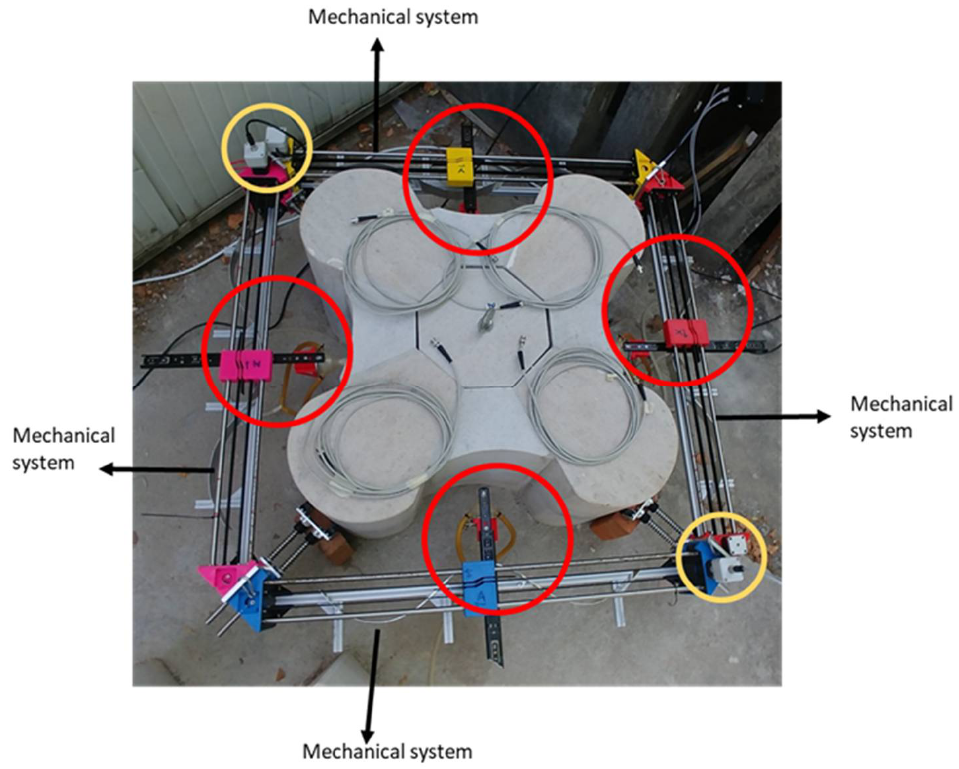
Figure 2. Ultrasonic tomography system developed. Red circle: coupling system with transducer + motion cart and yellow circle: motors.